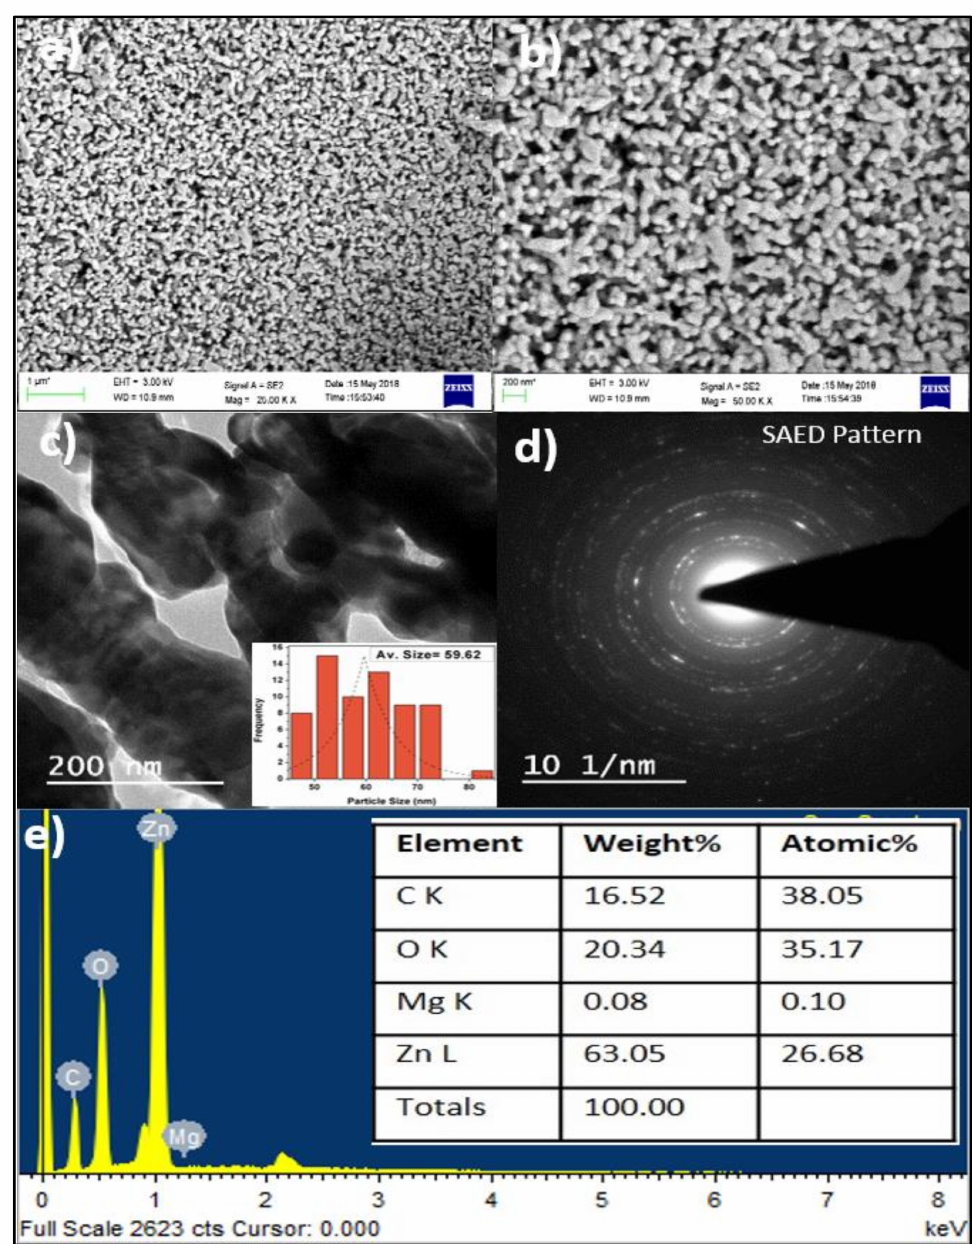
Figure 9. ( a , b ) FE-SEM micrographs; ( c ) HR-TEM images; ( d ) SAED pattern; ( e ) EDS spectra and elemental table of